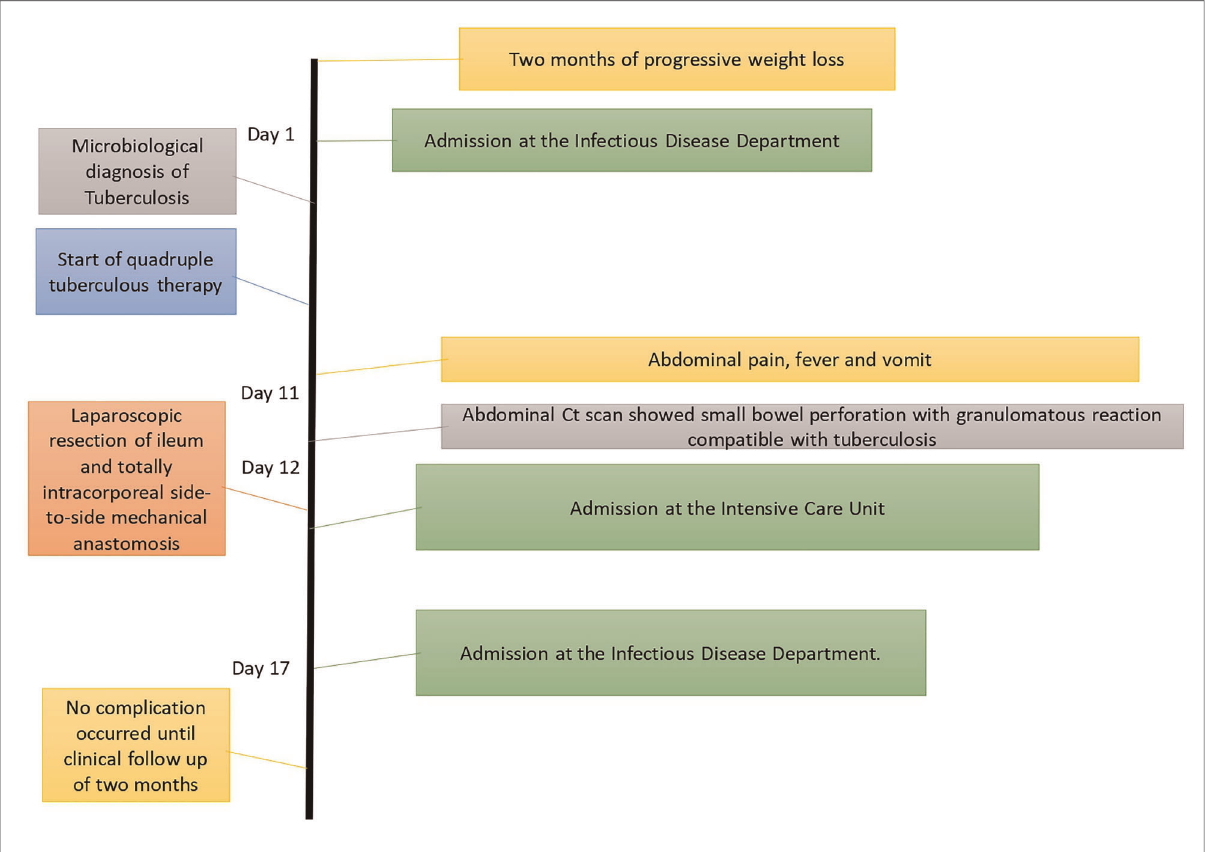
FIGURE 1 Timeline of diagnostic assessment, procedures, and